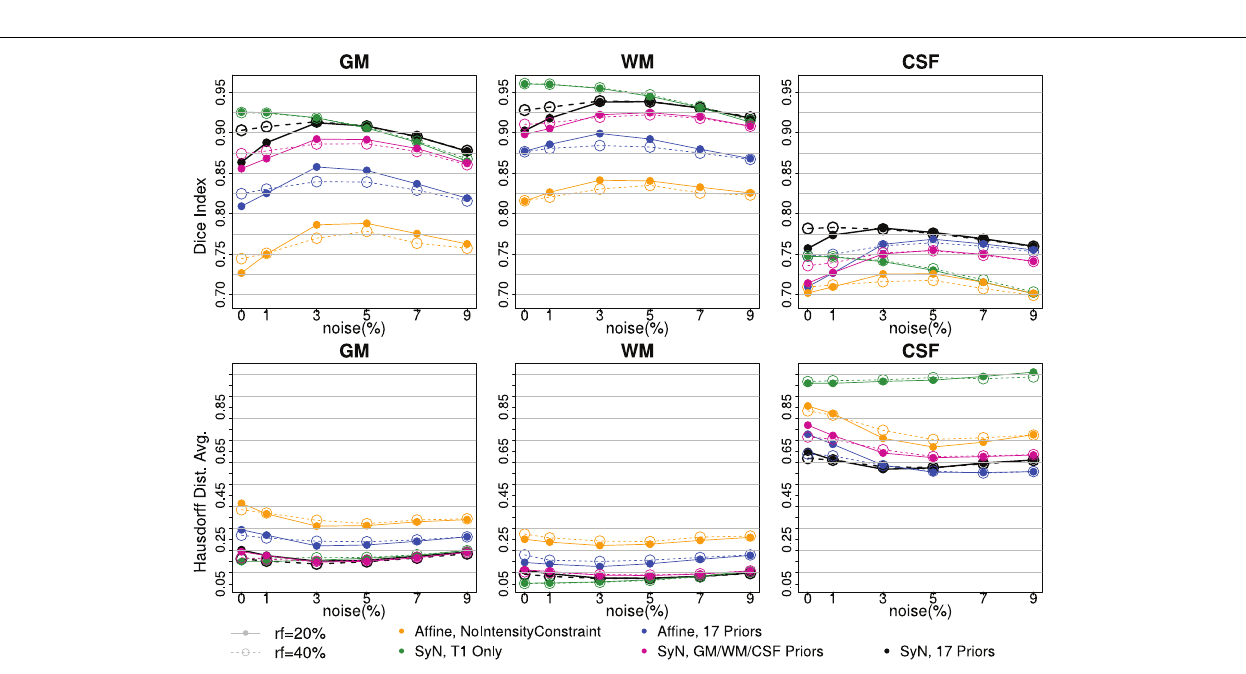
FIGURE 3 | Tissue classification agreement comparison to three-tissue based ground truth with BrainWeb Data. Two bias-fields, rf = 20 (solid line) and rf = 40 (dotted line), are shown with six noise levels along x-axis. Two independent measures of Dice Index (upper) and average Hausdorff Distance (bottom) are shown. With affine registration, Intensity-context prior (yellow) has better accuracy than one